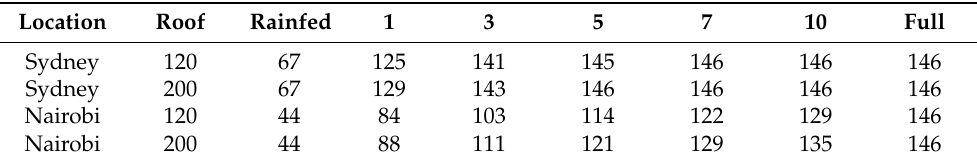
Table 2. Average yield (kg/year) for various RSS sizes (m 3 ) for 20 m 2 household agricultural (HA) area.